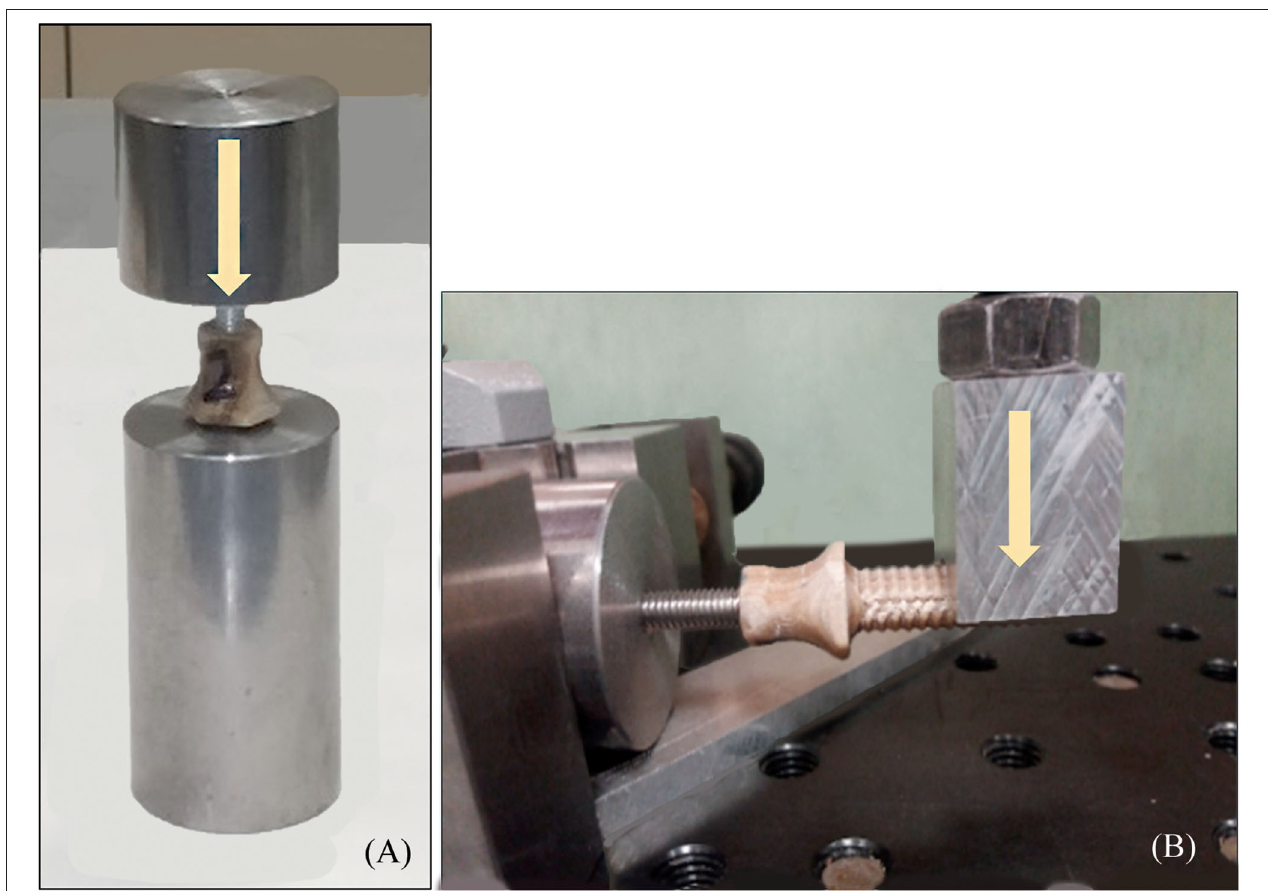
FIGURE 5 | (A) Pure compression (endoprosthesis at vertical position) and (B) bending test (endoprosthesis at horizontal position) of the endoprosthesis. Yellow arrows represent the direction of the applied